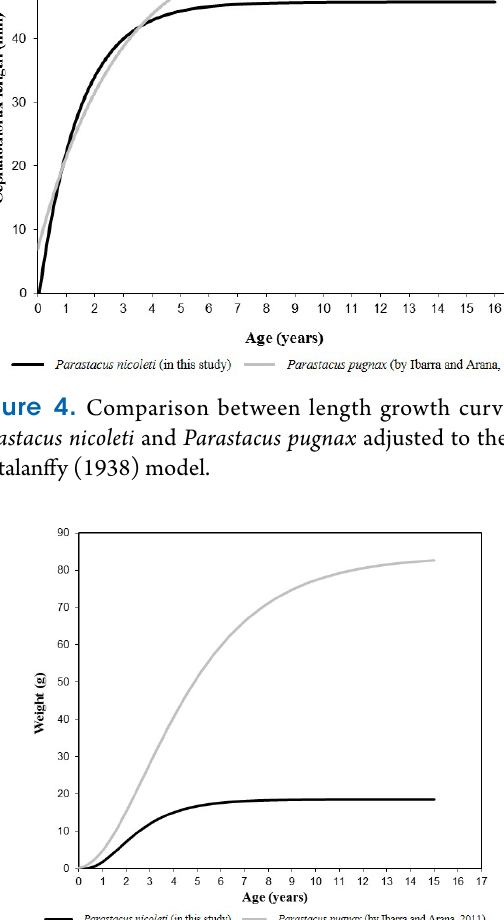
Figure 5. Comparison between weight growth curves of Parastacus nicoleti and Parastacus pugnax adjusted to the von Bertalanffy (1938)